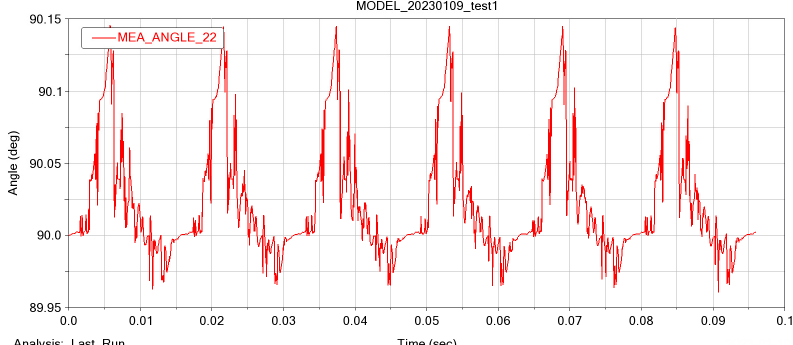
Figure 29. Torsional vibration of the second crank.